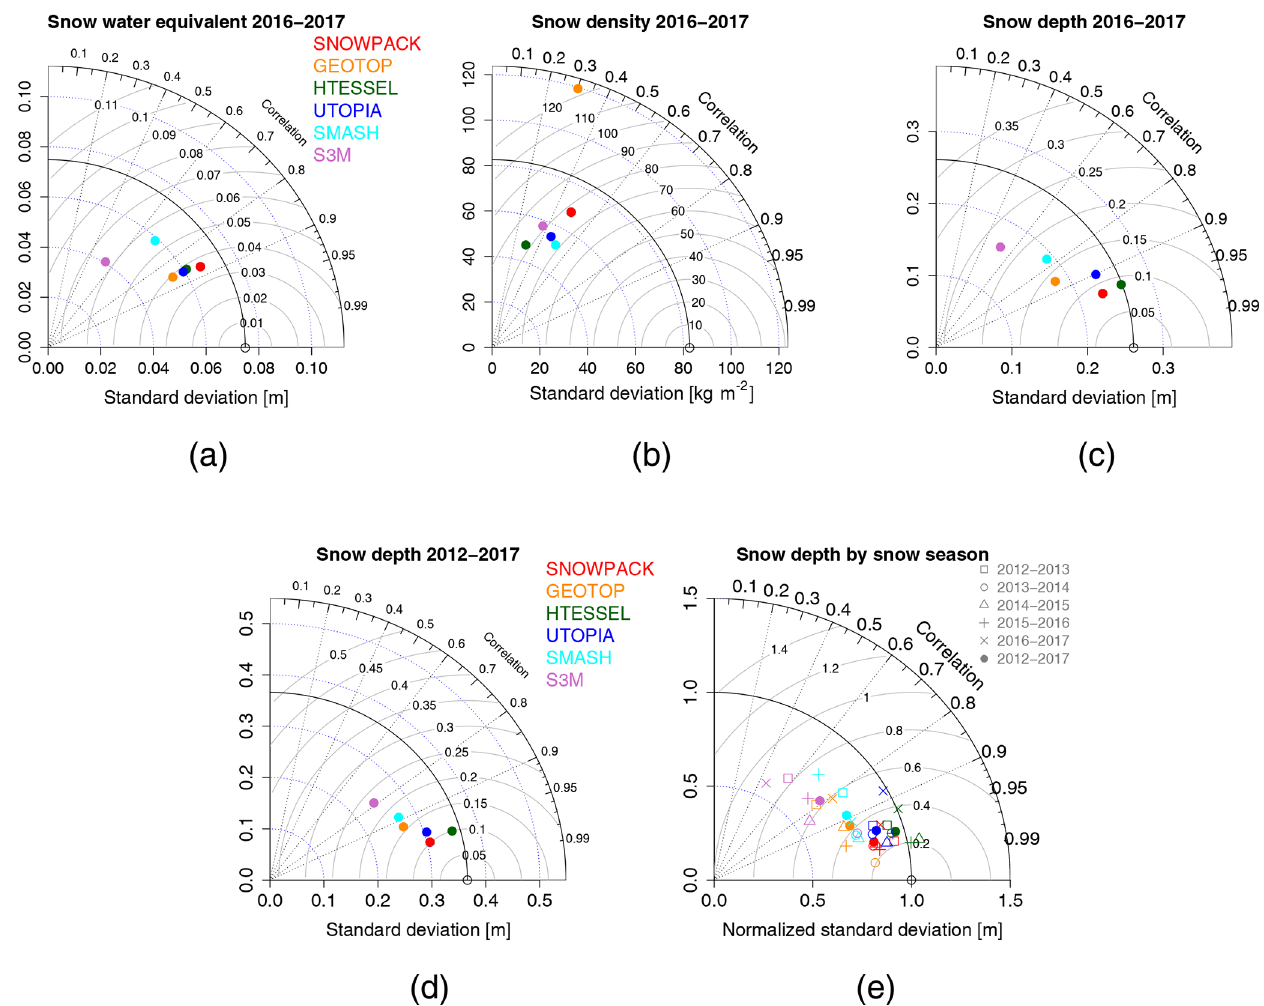
Figure 2. Taylor diagrams of the modelled vs. observed (a) snow water equivalent, (b) snow density and (c) snow depth in the control experiment (CTL) for the period 1 January 2016 to 30 June 2017. Bottom panels represent the statistics of snow depth (d) for the whole period 2012–2017 and (e) for each snow season in the same period. Differently from the other panels, in (e) model standard deviations are normalized with respect to the observed